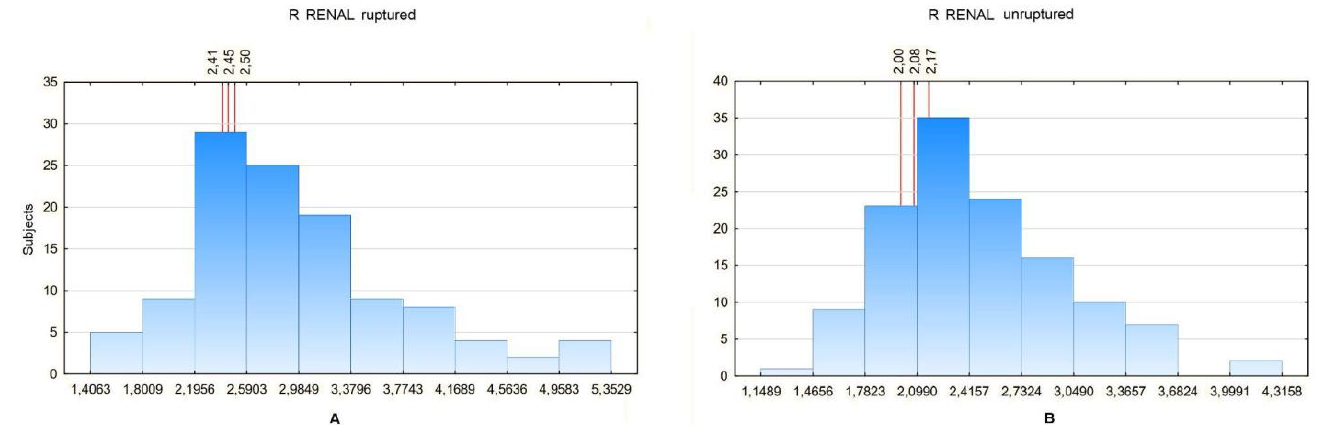
Figure 9. ( A ) R RENAL values distribution in a certain number of patients with ruptured aneurysm with neck segment present. For the 20th percentile: 2.41, 25th percentile: 2.45, 30th percentile: 2.5. ( B ) R RENAL values distribution in a certain number of patients with unruptured aneurysm with neck segment present. For the 20th percentile: 2, 25th percentile: 2.08, 30th percentile: 2.17. For aneurysms without necks, the values were 2.78 for 20%, 3 for 25% and 3 for 30%